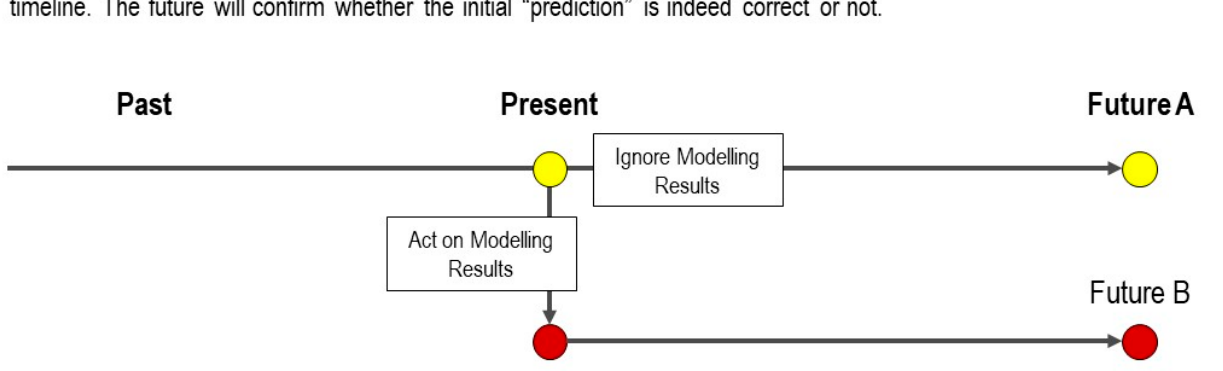
Figure 7. The time travel paradox of stability predictions.